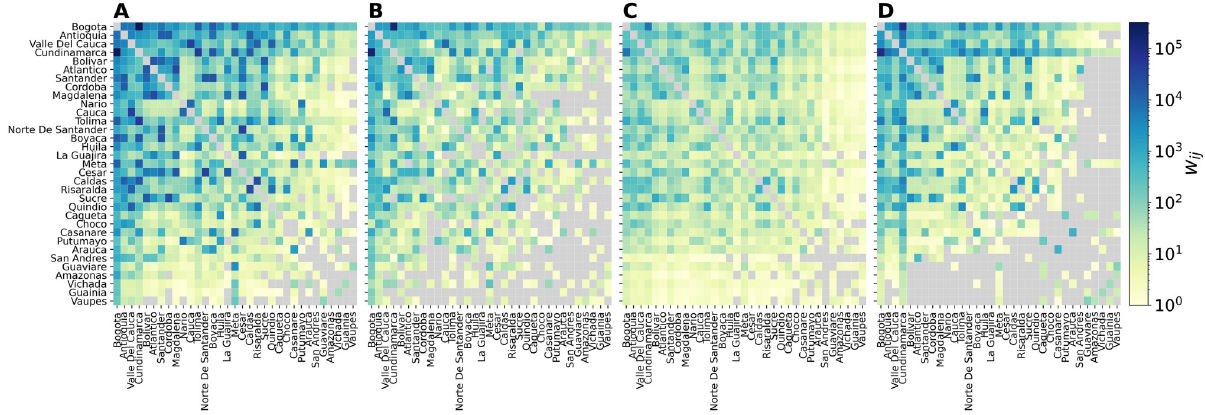
Fig 3. Mobility networks. Origin-destination matrices of the flows w ij among Colombian departments in the CDR-informed network (A), the census network (B), the gravity network (C), and the radiation network (D). The colour code represents the weights w movement). Departments are sorted according to population